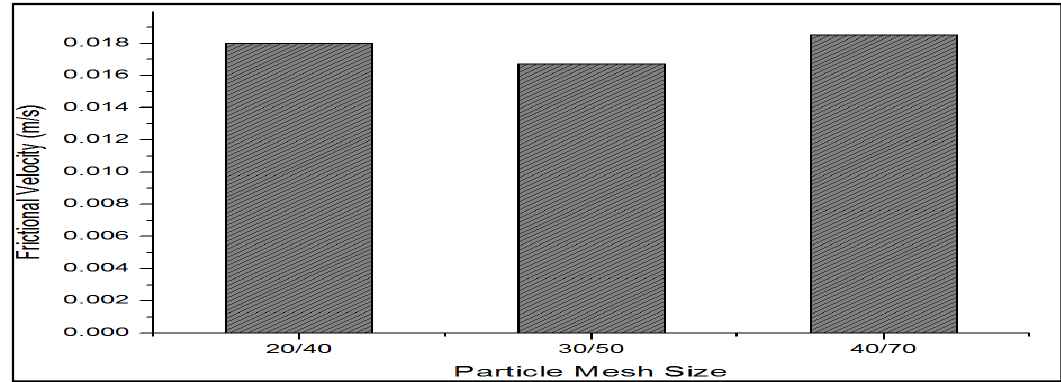
Figure 11. Friction velocity vs. the particle mesh size for the experiments conducted at the sub-critical velocity of 0.25 m/s.